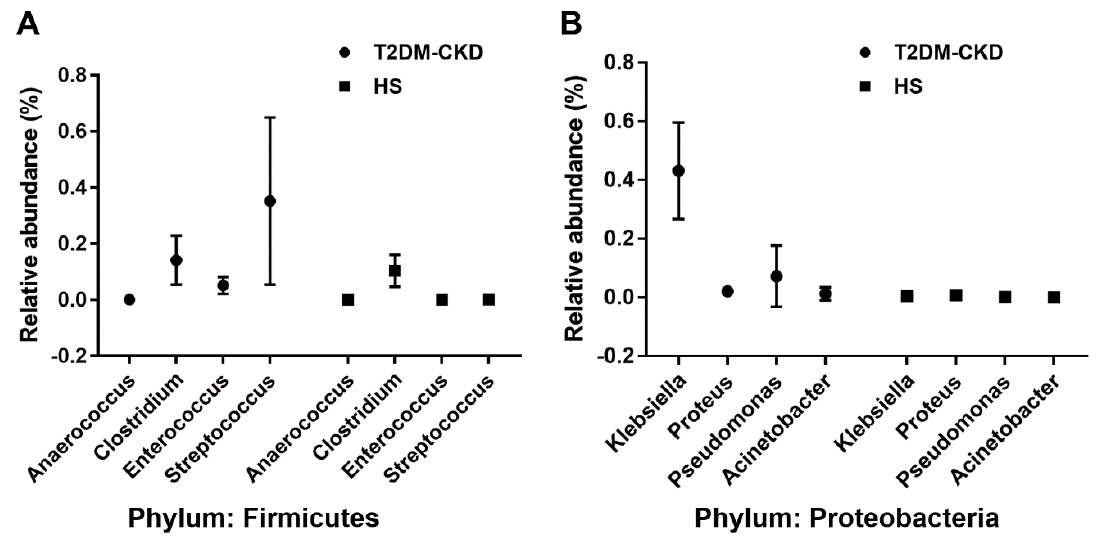
Figure 1. Relative abundance of four genera of bacteria in two phyla, Firmicutes ( A ) and Proteobacteria ( B ) associated with Trimethylamine N -Oxide (TMAO) production in the Type 2 Diabetes Mellitus (T2DM) and Healthy Subjects (HS) groups. p < 0.001; two-way ANOVA test with Bonferroni correction for multiple comparisons.